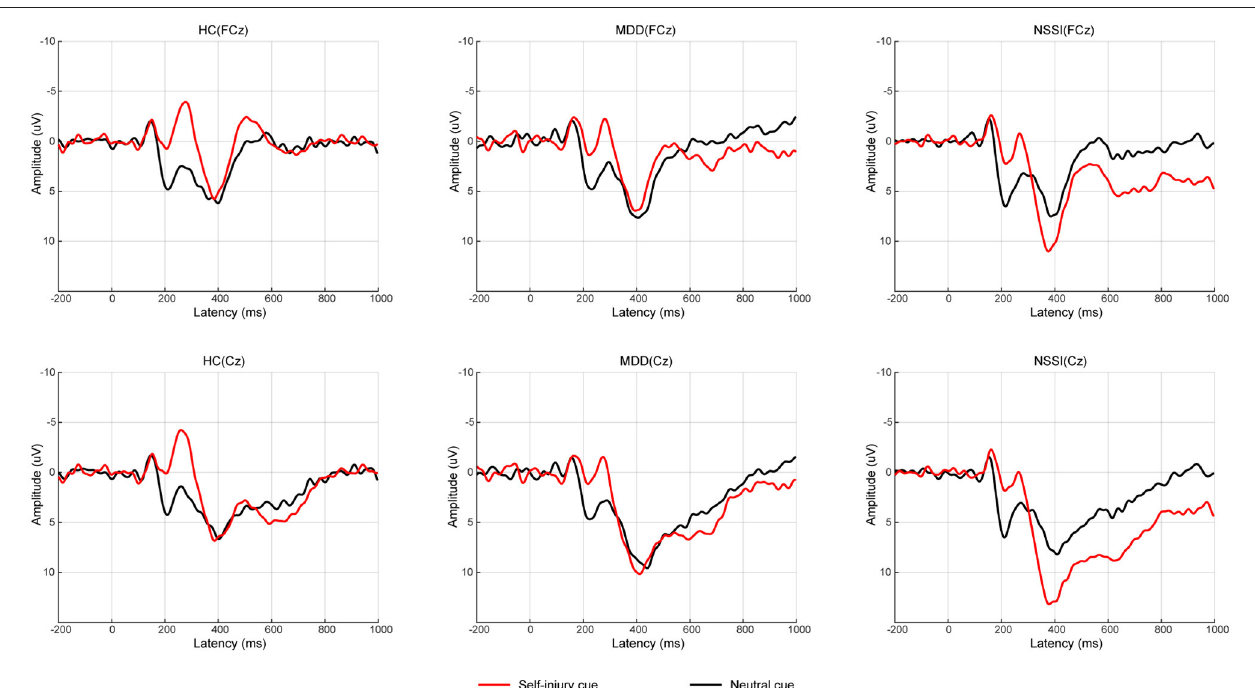
FIGURE 2 | Average of difference ERPs for neutral cue condition and self-injury cue condition in HC group, MDD group, and NSSI group. ERP, event-related potential; HC, healthy control; MDD, major depressive disorder; NSSI, nonsuicidal self-injury.